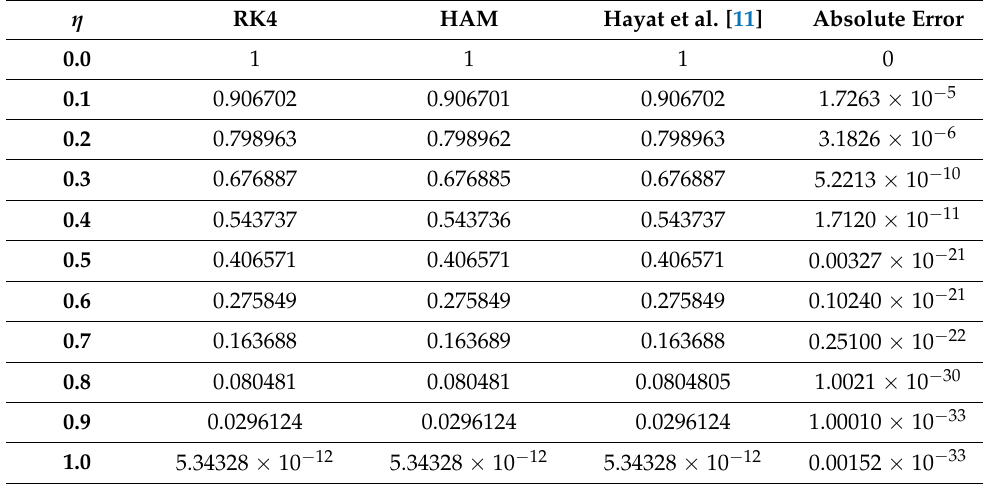
Table 1. Comparison of the present work with HAM and published